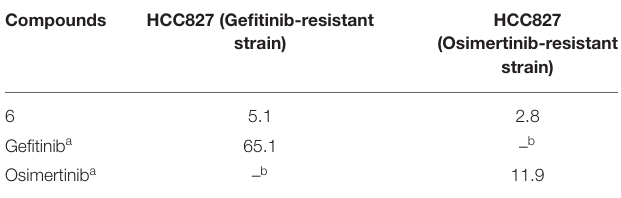
Osimertinib a a Used as positive controls. b Not